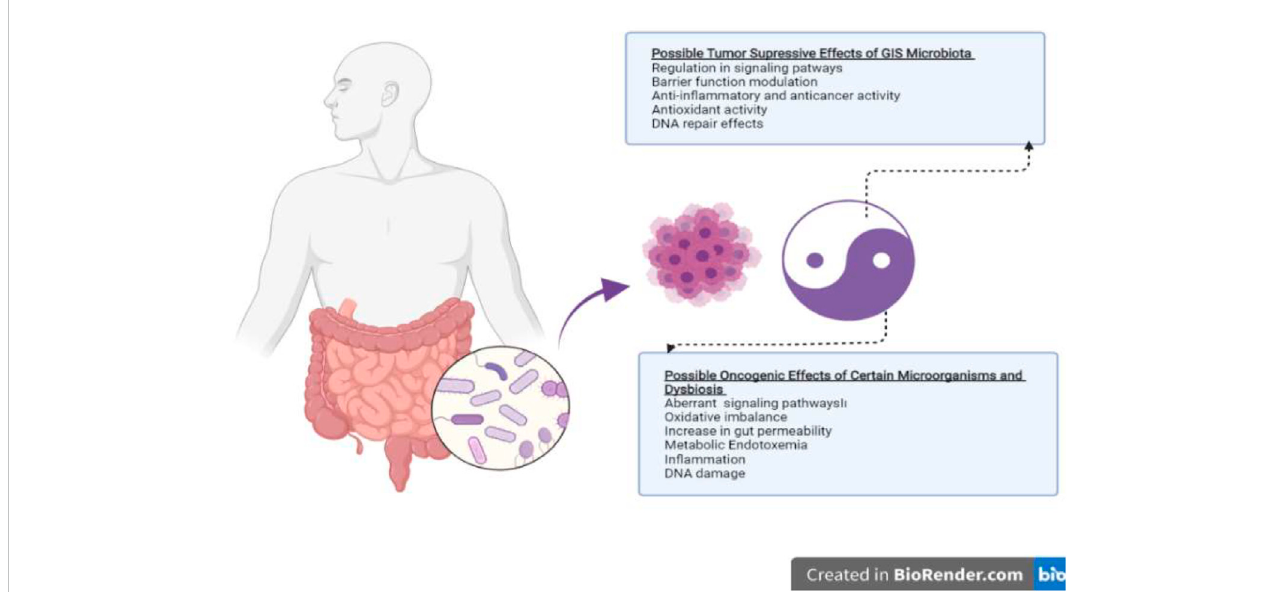
FIGURE 1 Putative mechanisms of action of the gut microbiome on tumor suppression and